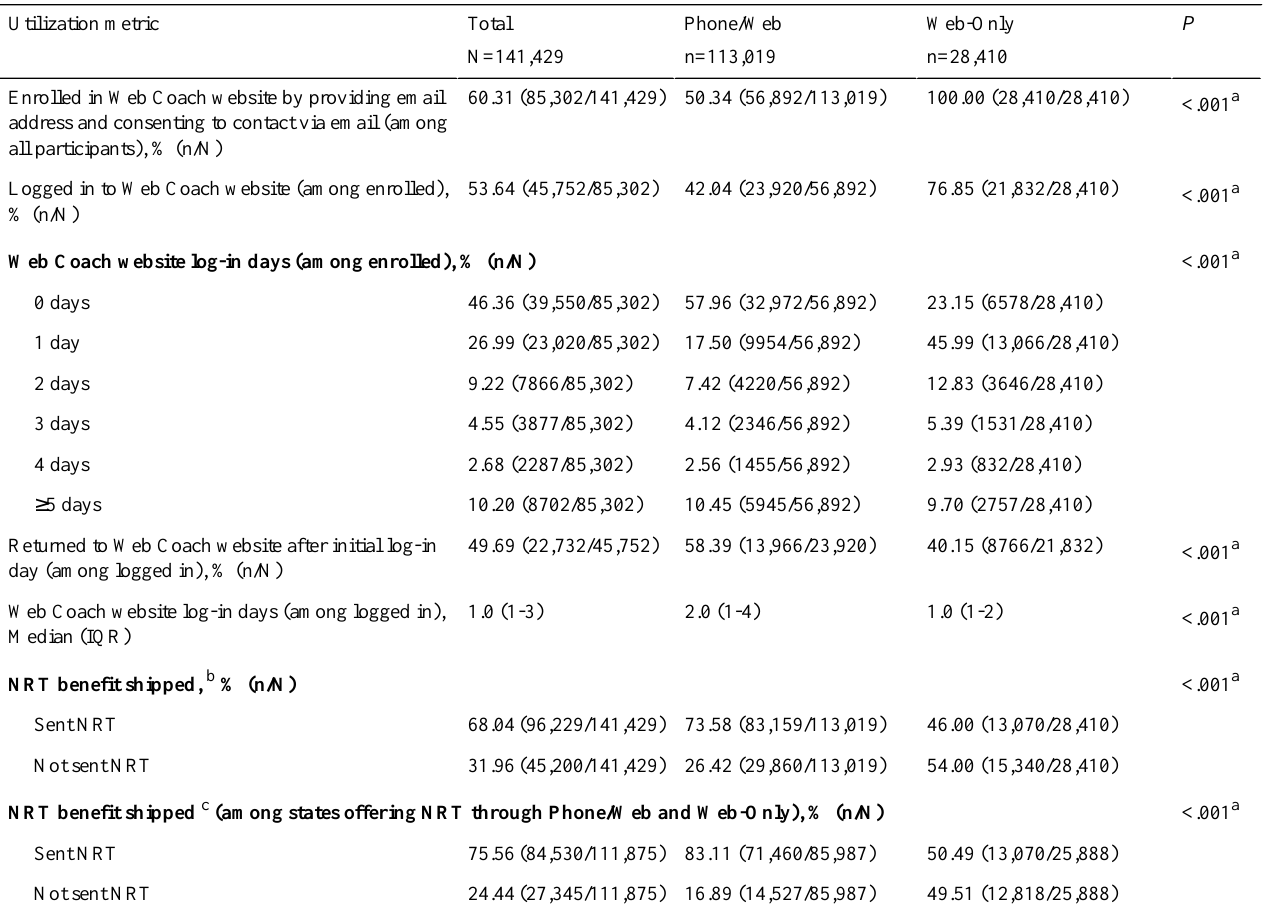
Table 3. Web Coach website enrollment rates, log-in days, return rates, and receipt of nicotine replacement therapy (NRT) benefit among total sample and between Phone/Web versus Web-Only